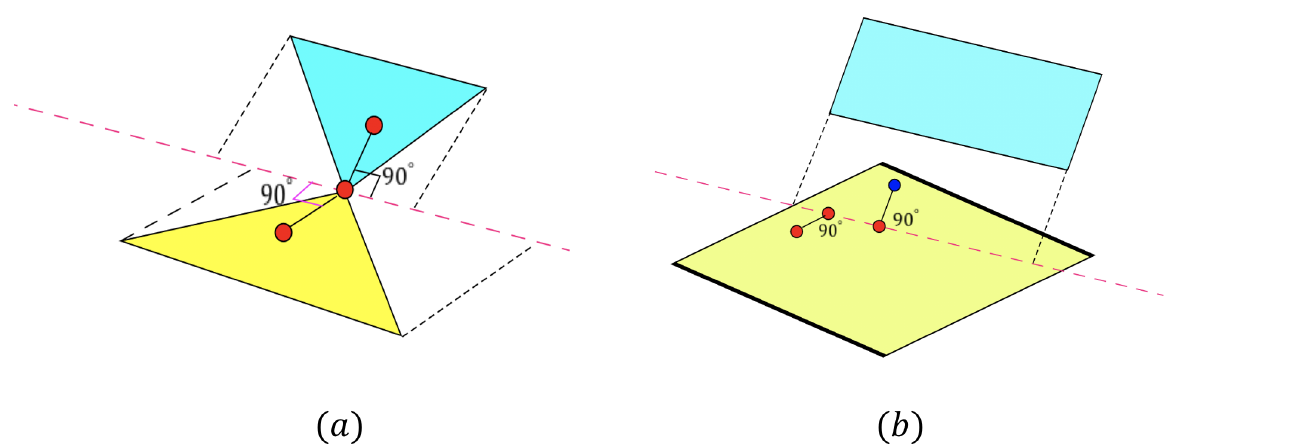
Figure 12. ( a ) Sliding checking model; ( b ) slide the model on the bending line; ( c ) the case of symmetry points. The reason for choosing four points rather than three to build the model is that three points are not enough to check the bending line in some special situations shown in Figure 13: In case ( a ) , two planes only intersect at one point, and there is not a completed bending line. If we only use three points to check, all three points can pass the checking on the area around the intersect point. However, there is not a completed bending line between the planes. For the case ( b ) , two planes do not contact each other, and the intersect line is on the expansion of the blue plane, so three red points really exist and can pass the checking with a small offset error error o . However, the blue point located on the expansion of the blue plane does not really exist. It won’t pass the checking with a big error o .